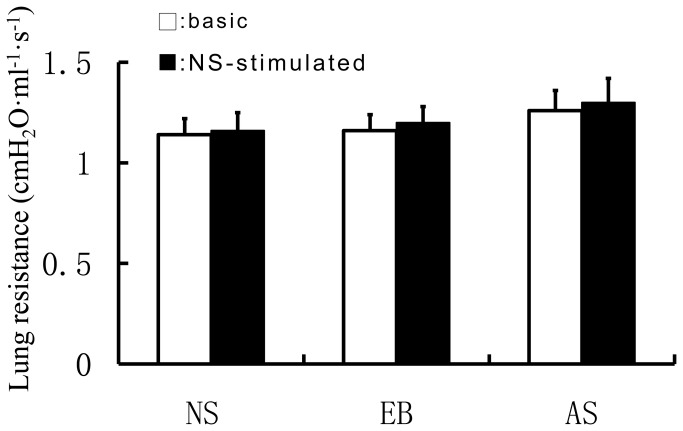
Comparison of lung resistance (RL) in mice when the models were set up and the normal saline (NS) control mice).